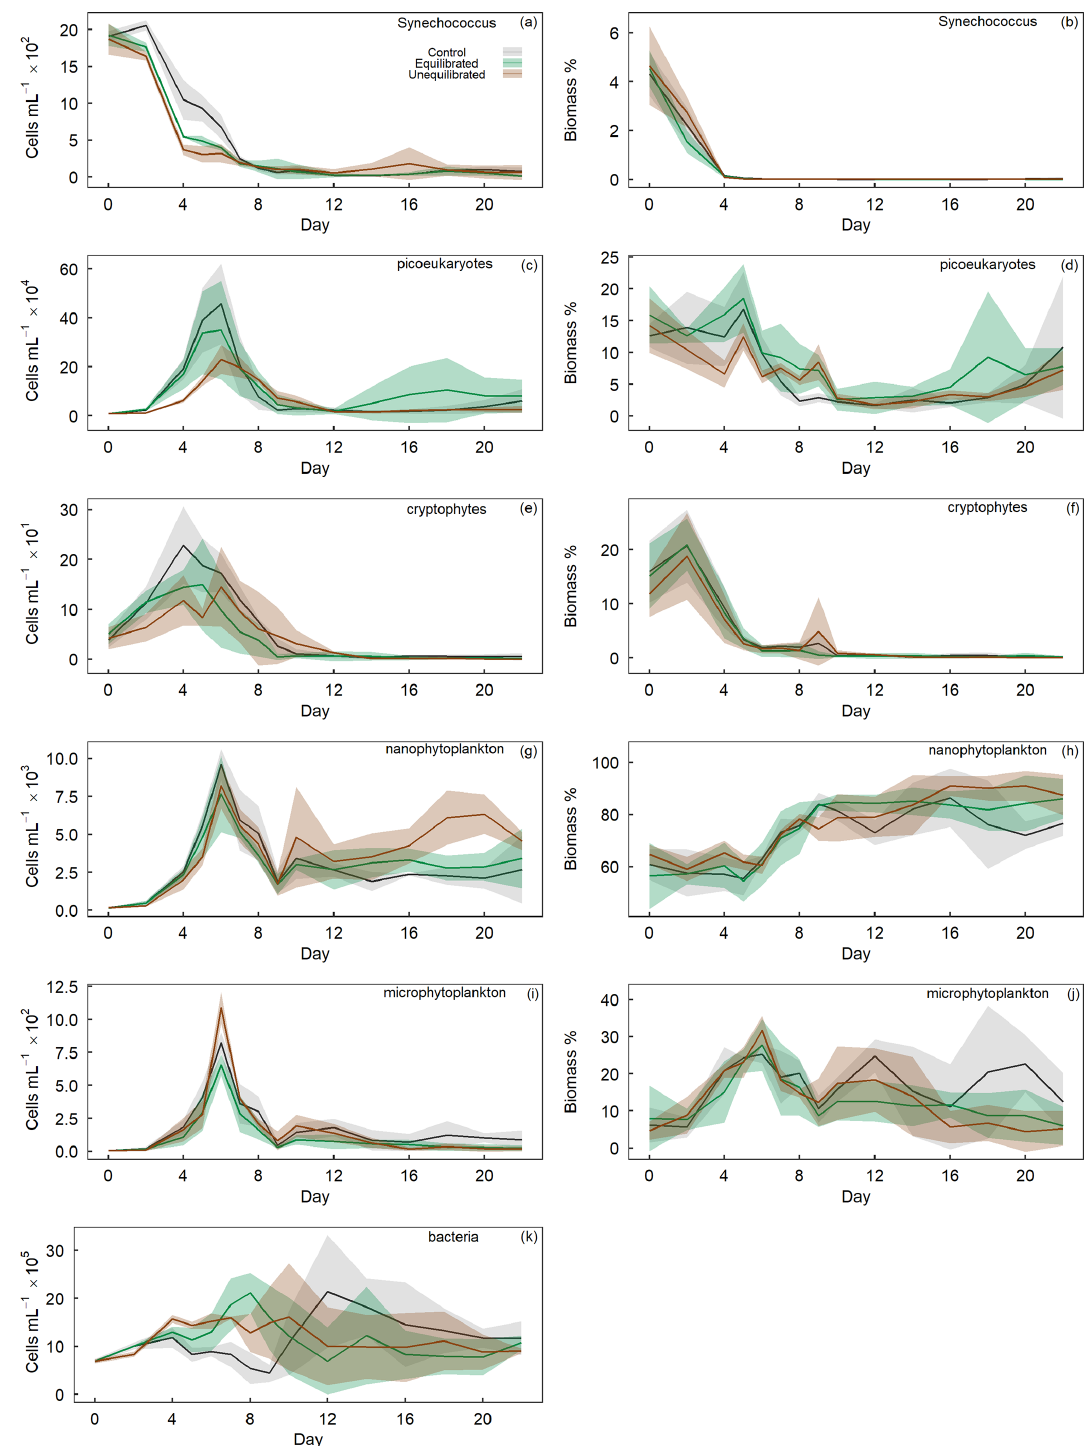
Figure 6. Temporal trends of phytoplankton group abundance (left column) and percent biomass contribution (right column) determined by flow cytometry. Group names provided in the top right of each plot. Coloured shading around the respective means represents standard deviation within a treatment